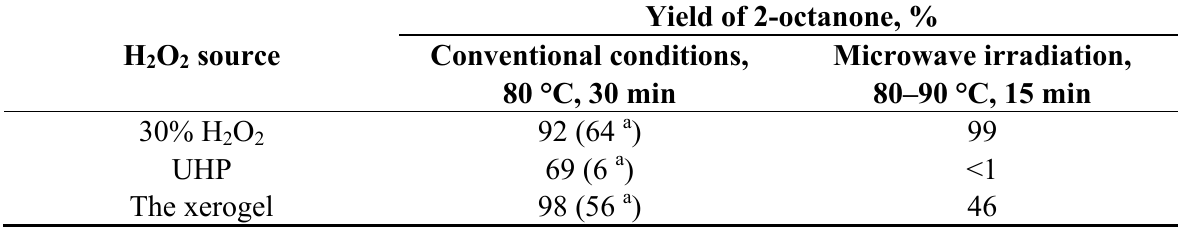
Table 2. Effect of the source of H microwaves